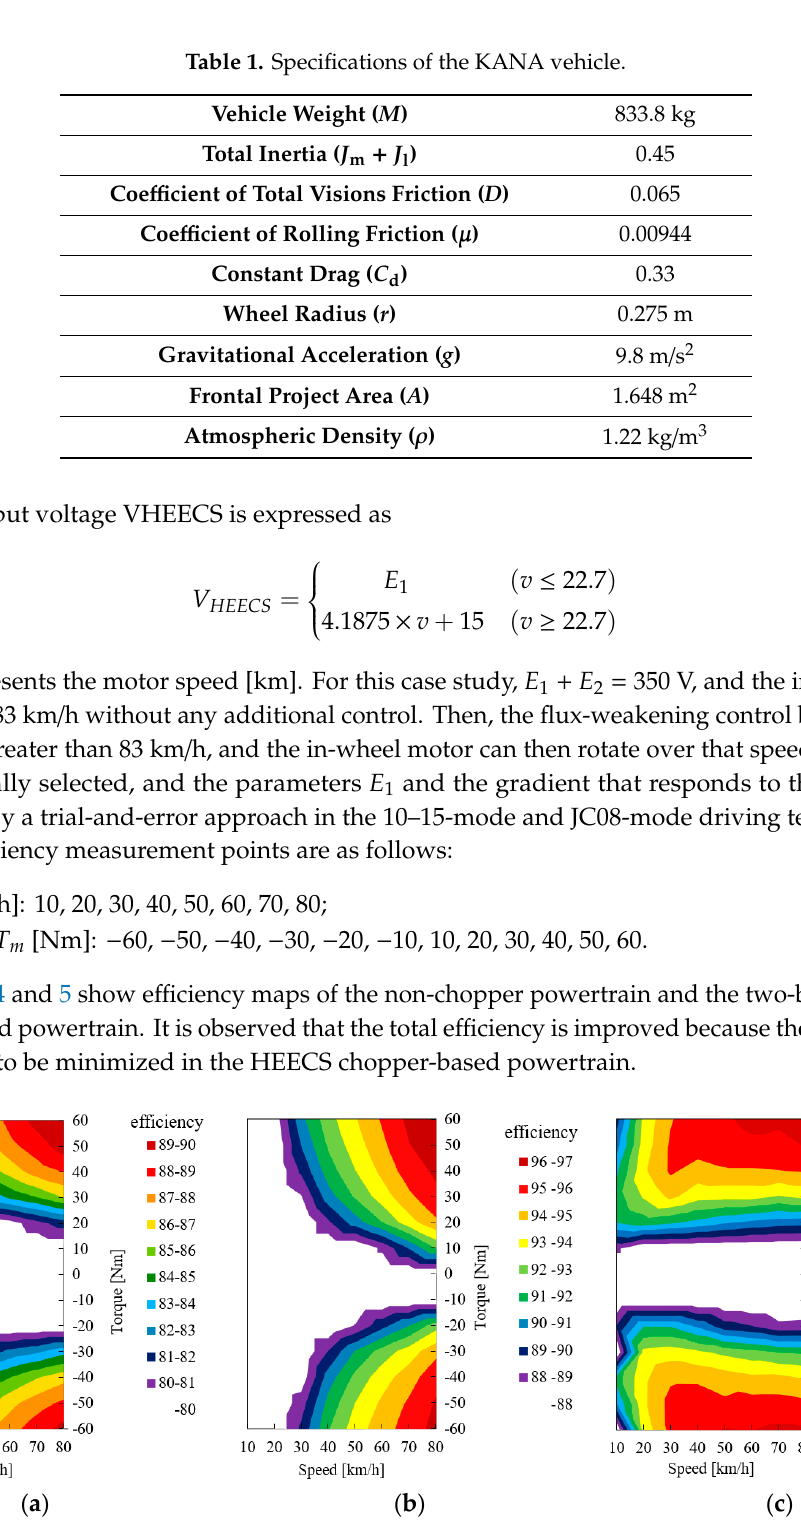
Figure 4. Efficiency maps of non-chopper powertrain: ( a ) Total efficiency; ( b ) inverter efficiency; ( c ) motor efficiency.